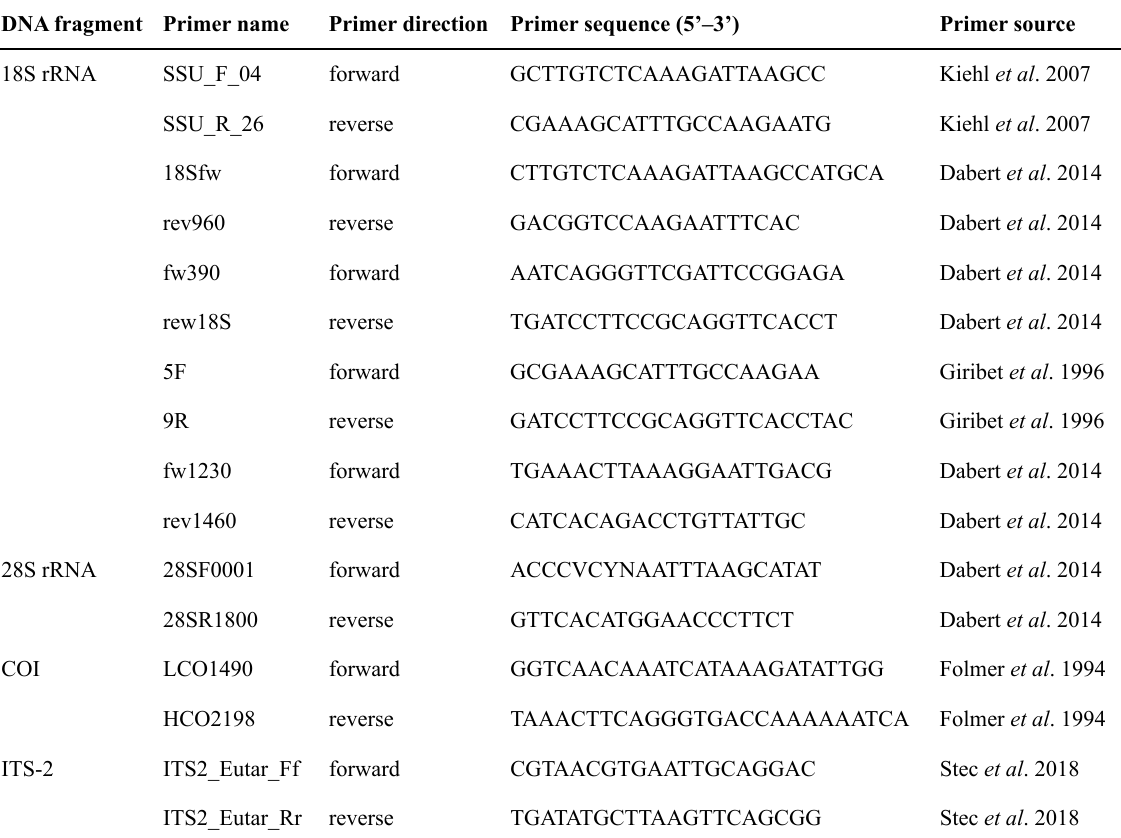
Table 1. Primers used for amplification of the four DNA fragments sequenced in the study. DNA fragment Primer